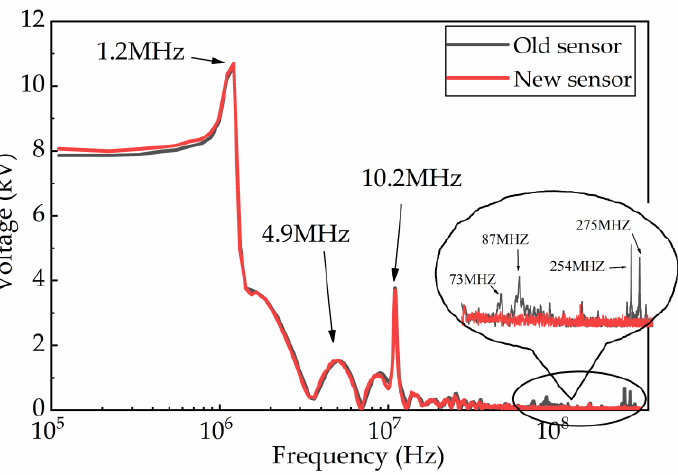
Figure 17. Full bandwidth spectrum of VFTO.